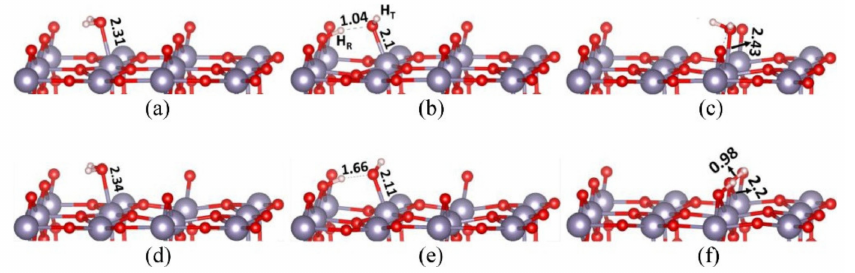
Figure 7. Adsorption of H 2 O onto ( a , b ) stoichiometric and ( c – f ) reduced (110) surfaces of SnO 2 . Adsorption energies are given for each configuration. ( a ) Molecular adsorption onto Sn 5c , − 1.29 eV. ( b ) Dissociative adsorption on Sn − 1.85 eV. ( c ) Molecular adsorption onto Vbr, − 0.81 5c , eV. ( d ) Molecular adsorption onto Sn 5c with a neighbouring V br , − 1.32 eV. ( e ) Disscheme 5. c with a neighbouring V br , − 1.92 eV. ( f ) Dissociative adsorption on V br , − 2.48 eV. Reproduced with permission from Reference